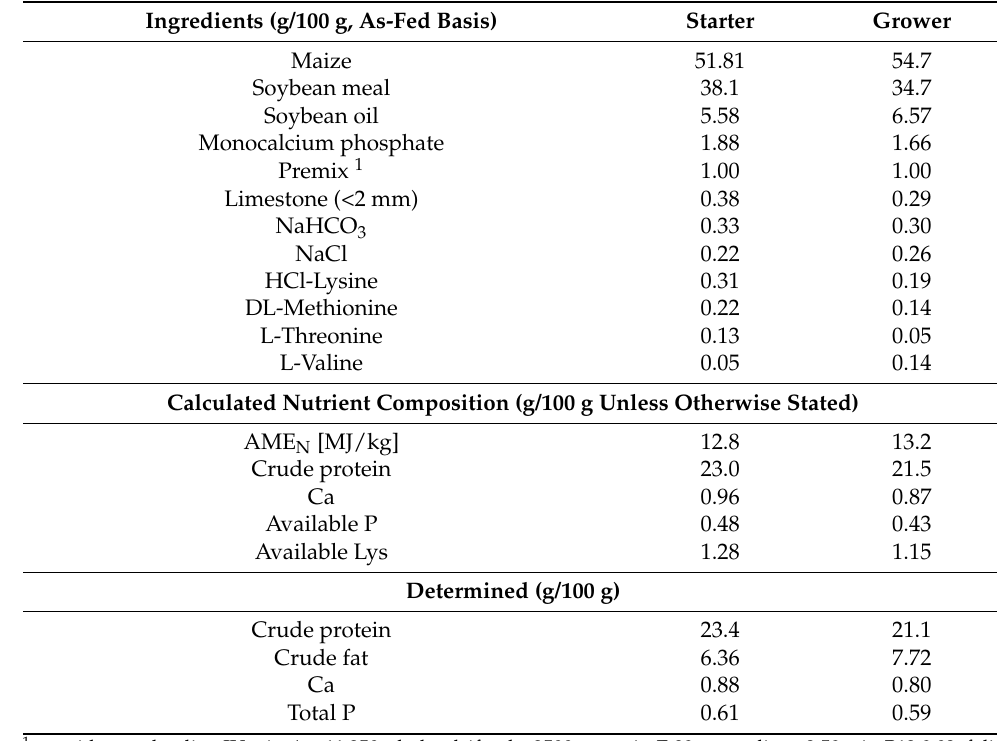
Table 1. Composition and nutrient contents of the diets. Ingredients (g/100 g, As-Fed